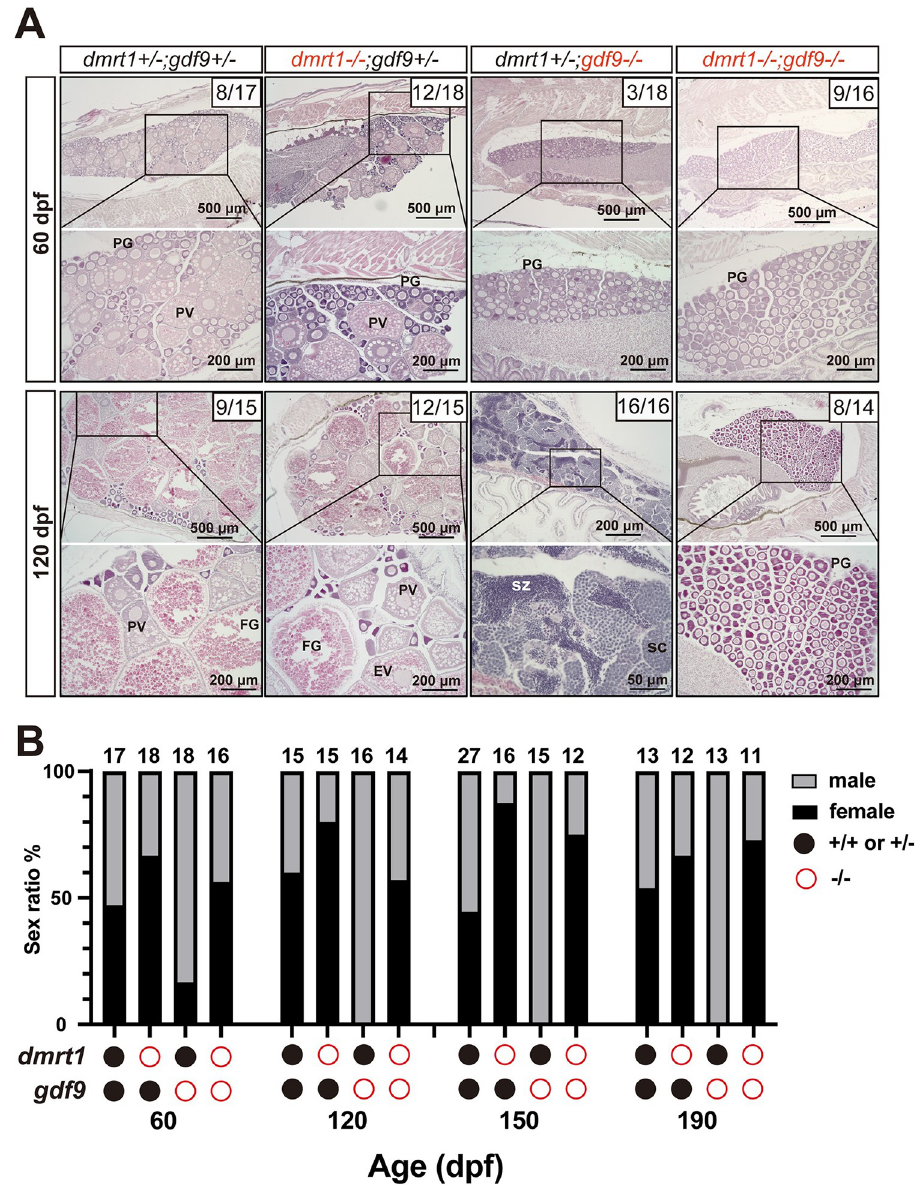
Fig 4. Prevention of sex reversal of gdf9 mutant by dmrt1 mutation. (A) Gonadal histology at 60 and 120 dpf. Ovary could form in the control ( dmrt1 +/- ;gdf9 +/-), single mutants ( dmrt1 -/- and gdf9 -/-) and double mutant ( dmrt1 -/- ; gdf9 -/-) as seen at 60 dpf. The gdf9 -/- single mutant became all males at 120 dpf (16/16 fish examined in total) whereas most individuals of the double mutant were females (8/14 examined), similar to that in the control (9/15). The numbers shown in the photos indicate the total number of fish examined (lower) and the number of female fish exhibiting similar phenotype to that shown (upper). (B) Change of sex ratio during 60–190 dpf. The offspring from one crossing ( dmrt1+/-;gdf9 +/- female X dmrt1+/-;gdf9 +/- male) were sampled at different times from 60 to 190 dpf for genotyping and sex identification by histology. The gdf9 -/- fish showed a male-biased sex ratio at 60 dpf, and it became all-male from 120 dpf due to sex reversal. Double mutation with dmrt1 rescued the sex ratio to the control level with even higher female ratios at 150 and 190 dpf. PG, primary growth; PV, pre-vitellogenic; FG, full-grown; SC, spermatocytes; SZ,